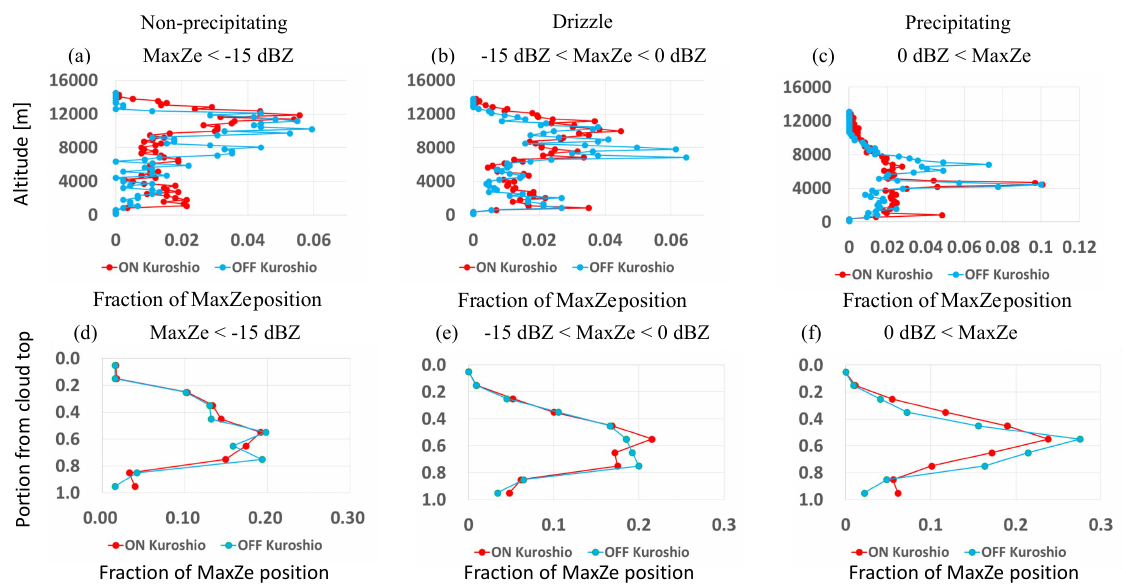
Figure 7. The relationship between the fraction of the maximum radar reflectivity (MaxZe) position and altitude according to the three categories of MaxZe for (a) non-precipitating, (b) drizzle, and (c) precipitating clouds. The fraction of the MaxZe position for the scaled cloud layer according to the three categories of MaxZe for (d) non-precipitating, (e) drizzle, and (f) precipitating clouds.